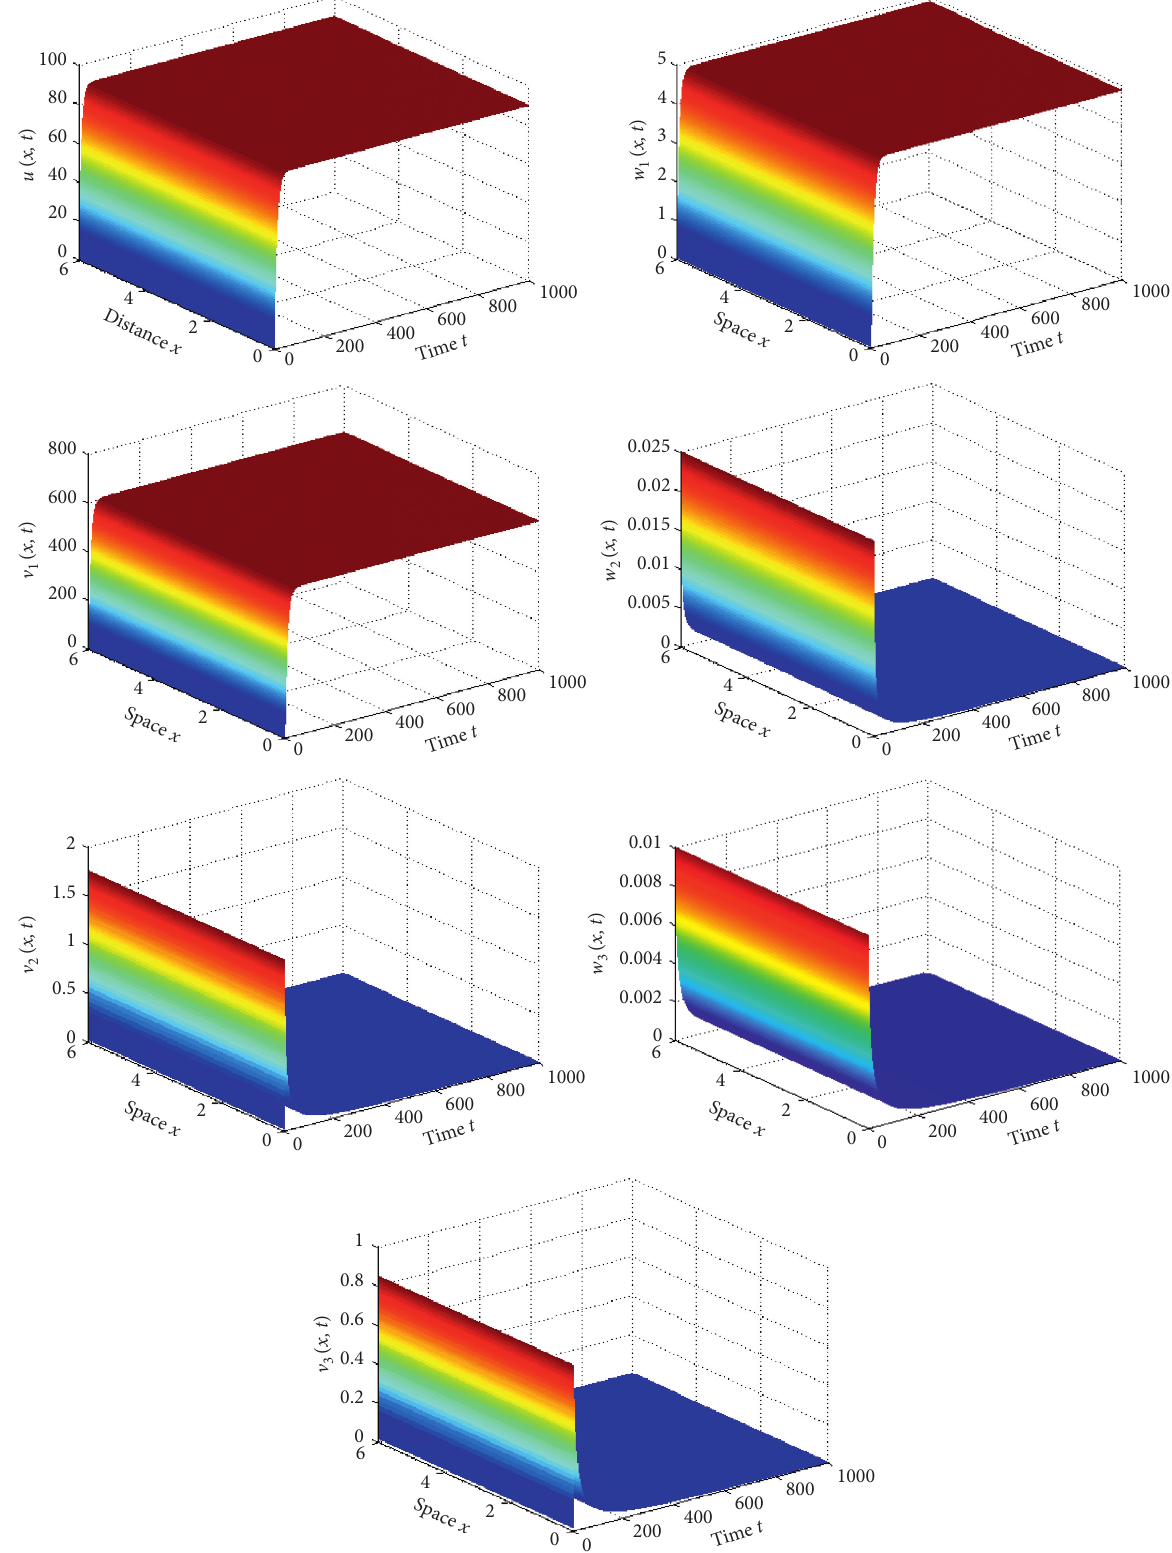
Figure 4: Taking m 1; β